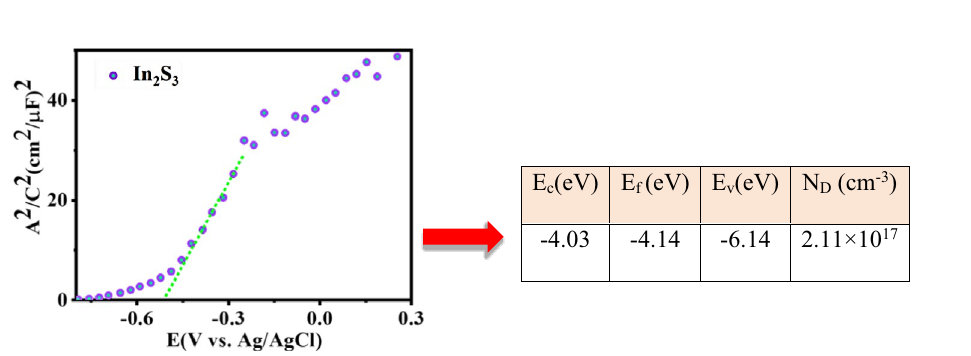
Figure 5. The Mott–Schottky (M–S) analysis curve of In 2 S 3 layers measured in 0.5 M Na 2 SO 4